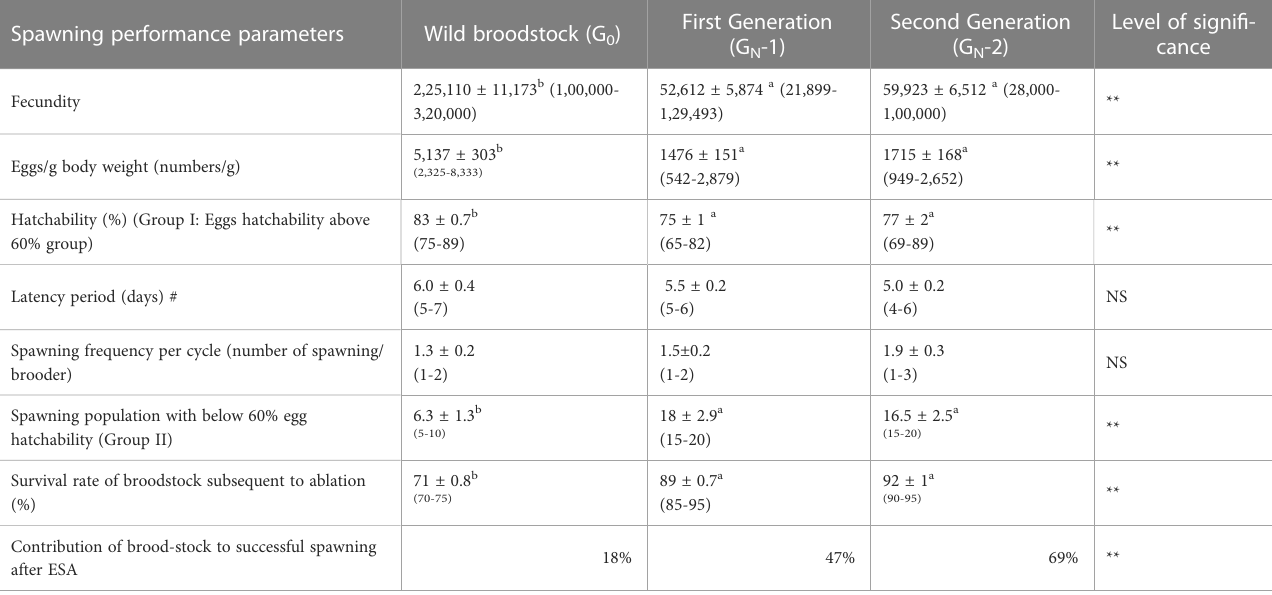
TABLE 3 The average (mean ± SE) and range of spawning performance parameters of wild (G 0 ) and captive-reared Penaeus indicus fi rst (G N -1) and second-generation (G N -2) broodstocks are based on one way